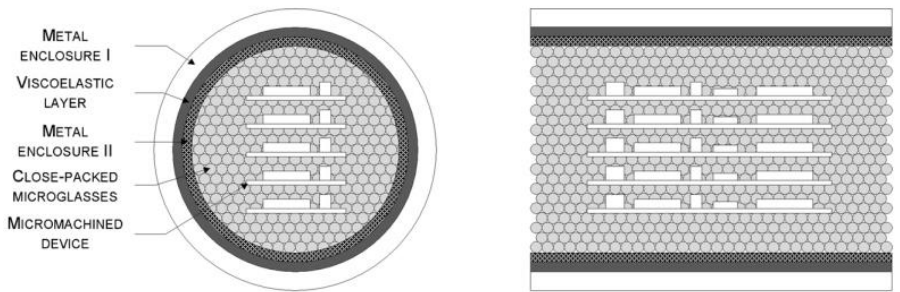
Figure 7. Bionic vibration absorption system [45].